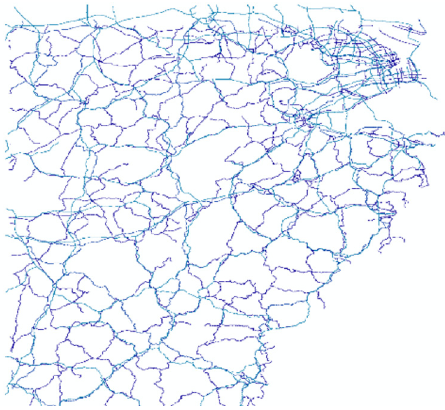
Figure 3. Rectangular